Question: Write a caption explaining this figure to a reader.
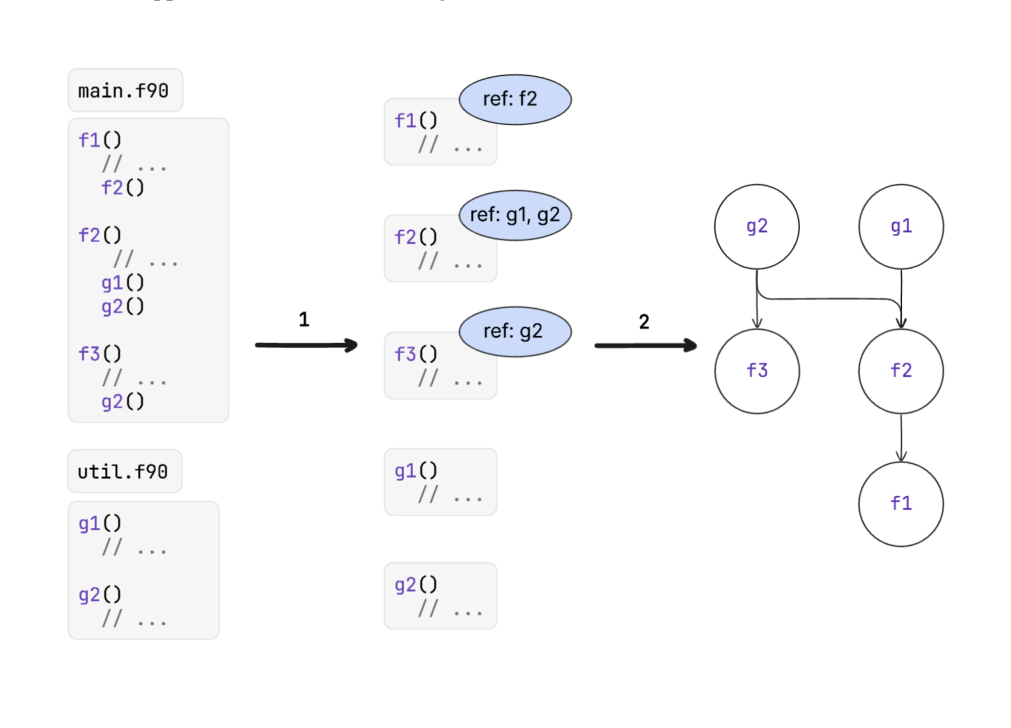
Answer: Visualization of code chunking process. In step 1, we chunk a codebase into individual units using a parsing tool and trace references. In step 2, we use those references to form a dependency graph.